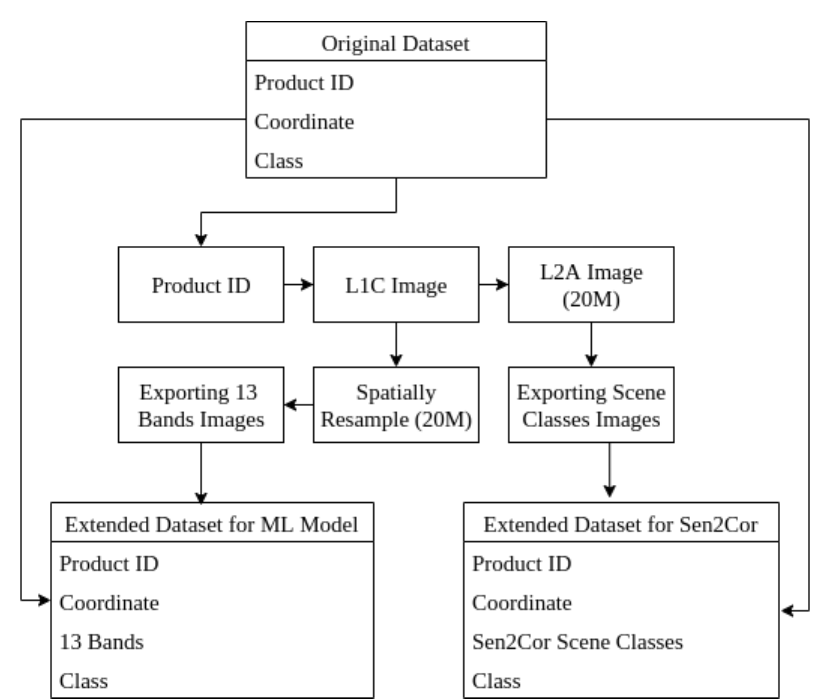
Figure 2. Generation of the Extended Database for Machine Learning (ML) and Sen2Cor Assessment.